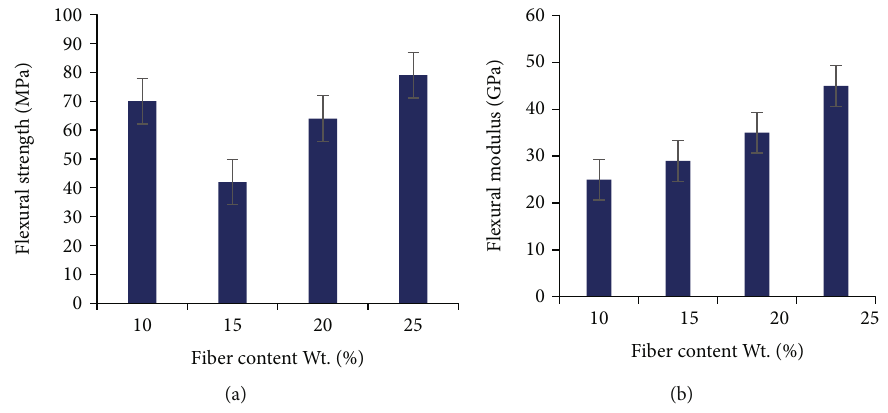
Figure 4: (a) Flexural strength vs. fi ber content and (b) fl exural modulus vs. fi ber content.